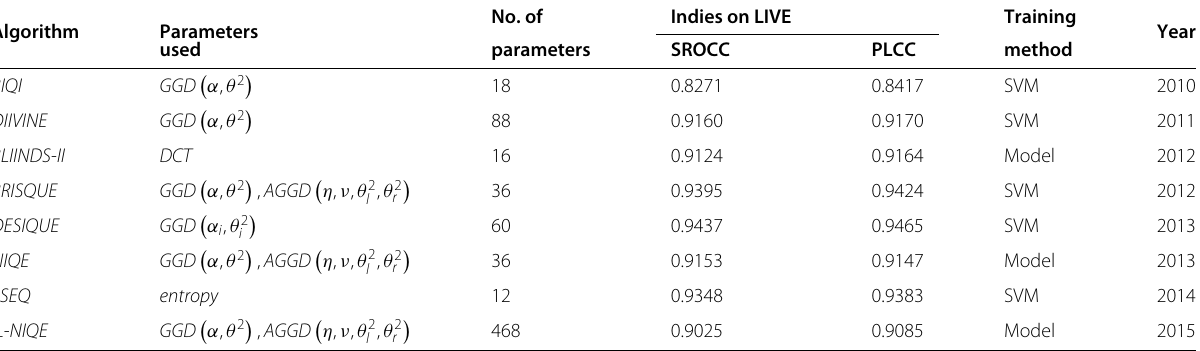
Table 1 Explicit NR-IQA algorithm performance comparison Algorithm